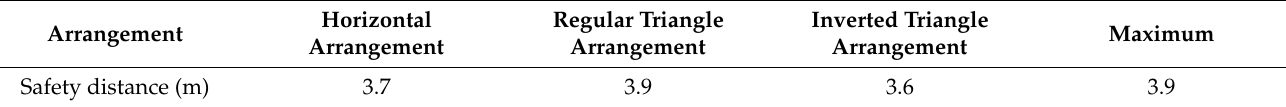
Table 4. Safety distance under different arrangement modes of 220